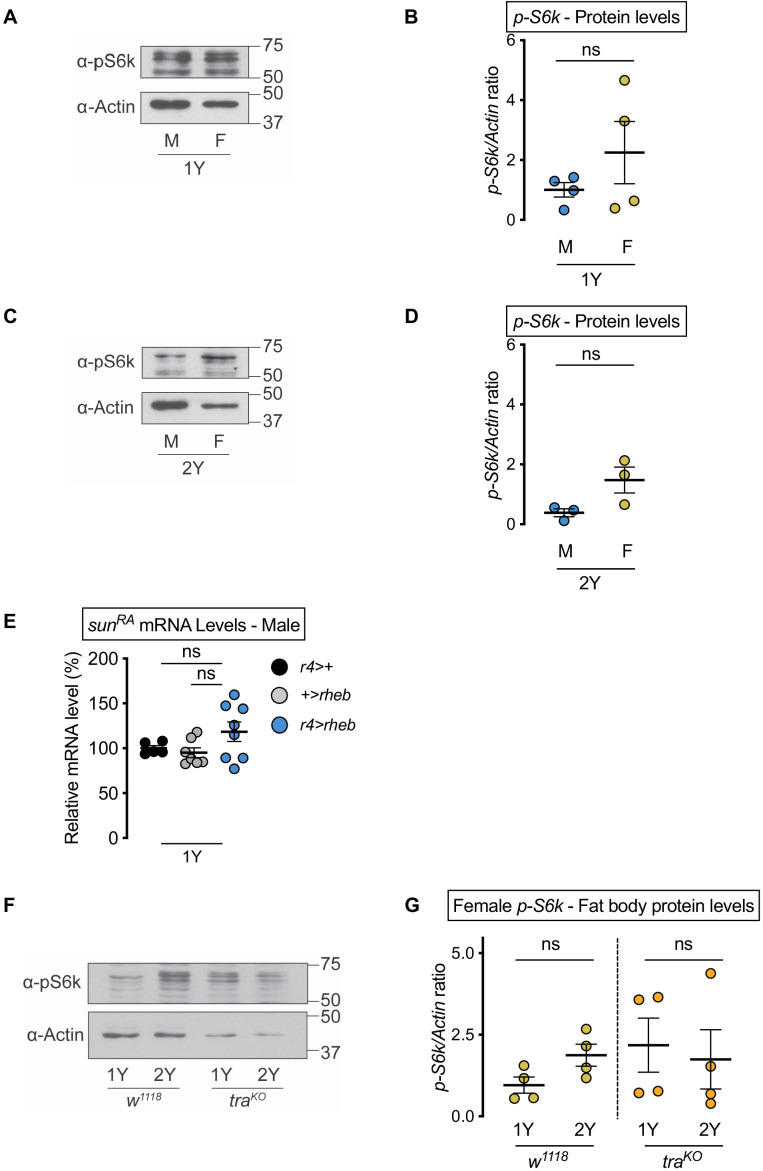
No nutrient- or transformer-dependent sex difference in fat body Target-of-rapamycin (TOR) signaling activity.(A) Levels of phosphorylated S6 kinase (pS6k) were quantified in dissected fat bodies from w1118 male and female larvae cultured in 1Y. (B) pS6k levels were not different between males and females in 1Y (p=0.2896; Student’s t test). n = 4 biological replicates. (C) Levels of pS6k were quantified in dissected fat bodies from w1118 male and female larvae cultured in 2Y. (D) pS6k levels were not different between males and females in 2Y (p=0.0732; Student’s t test). n = 3 biological replicates. (E) mRNA levels of stunted (sunRA) were not significantly different in r4-GAL4>UAS-rheb males compared with r4-GAL4>+ and +>UAS-rheb control males (p=0.3229 and p=0.1252, respectively; one-way ANOVA followed by Tukey HSD test). n = 5–8 biological replicates. (F) Levels of pS6k were quantified in dissected fat bodies from female w1118 and female transformer (tra) mutant larvae cultured in 1Y and 2Y. (G) pS6k levels were not different between female w1118 and female traKO in either 1Y or 2Y (p=0.0702 and p=0.737, respectively; Student’s t test). n = 4 biological replicates. ns indicates not significant; error bars indicate SEM.